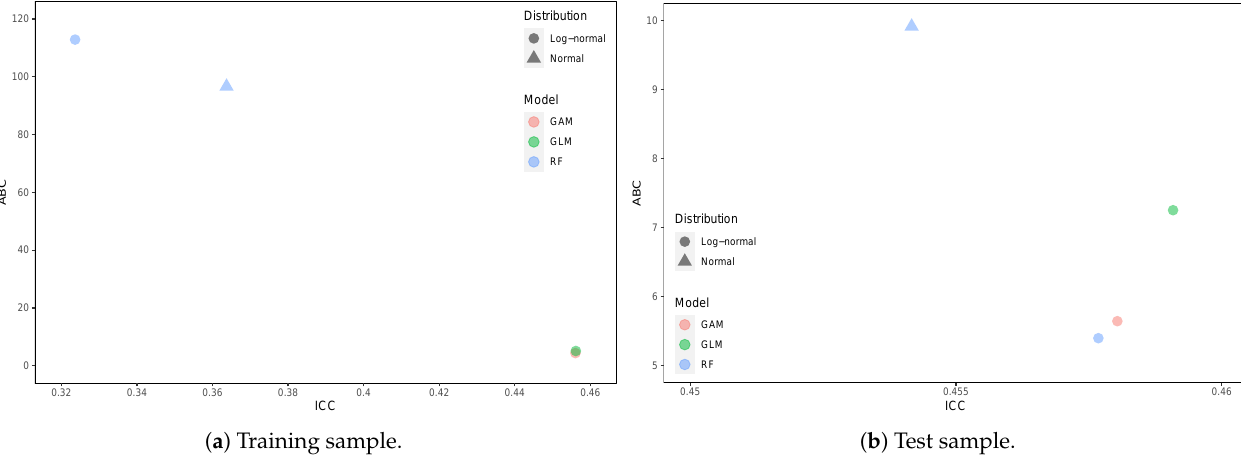
Figure 9. Illustration of the ABC and ICC GOL statistics in the training and test